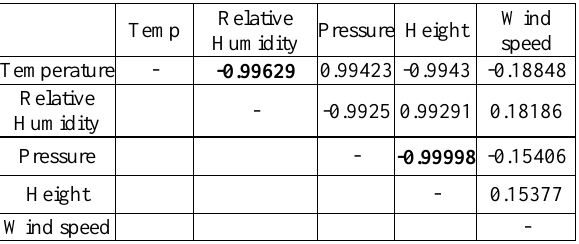
Table 5. Pearson correlation coefficients of independent variables